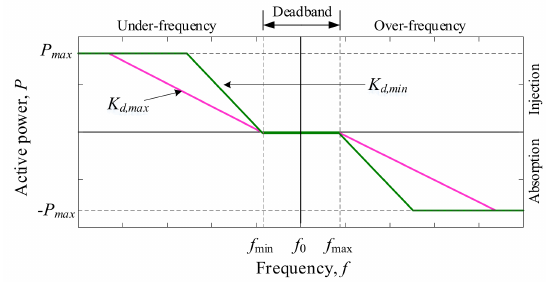
Figure 5. Power–frequency characteristic of the proportional fast active power (PFAP)